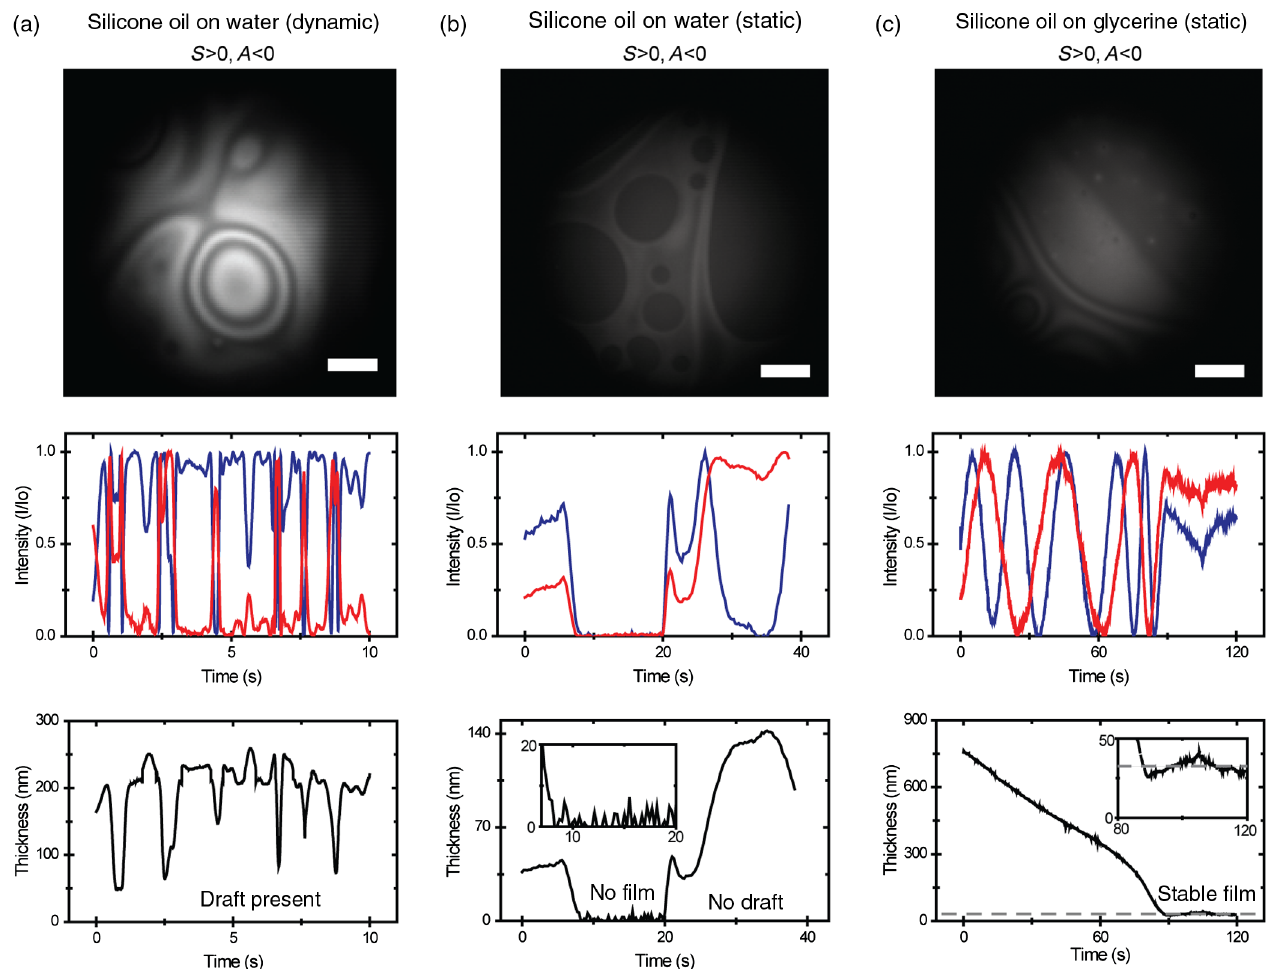
FIG. 12. Evolution of the wrapping layer thickness and profile in time as measured using dual-wavelength RICM. (a) Silicone oil forms thick films on a droplet of water due to the presence of ambient airflow leading to fluctuating thickness measurements. (b) Because of the positive Hamaker constant, thin films of silicone oil on water dewet in the absence of airflow. (c) Silicone oil thin films reach a stable equilibrium thickness on a glycerine droplet due to the negative Hamaker constant, even in the absence of ambient airflow.